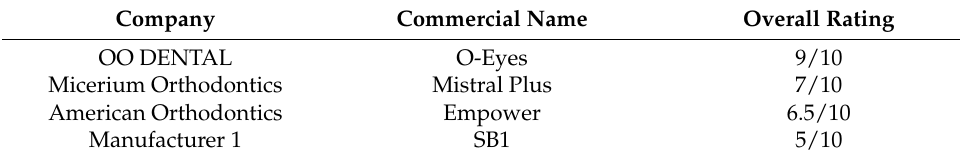
Table 9. Self-ligating brackets overall rating.